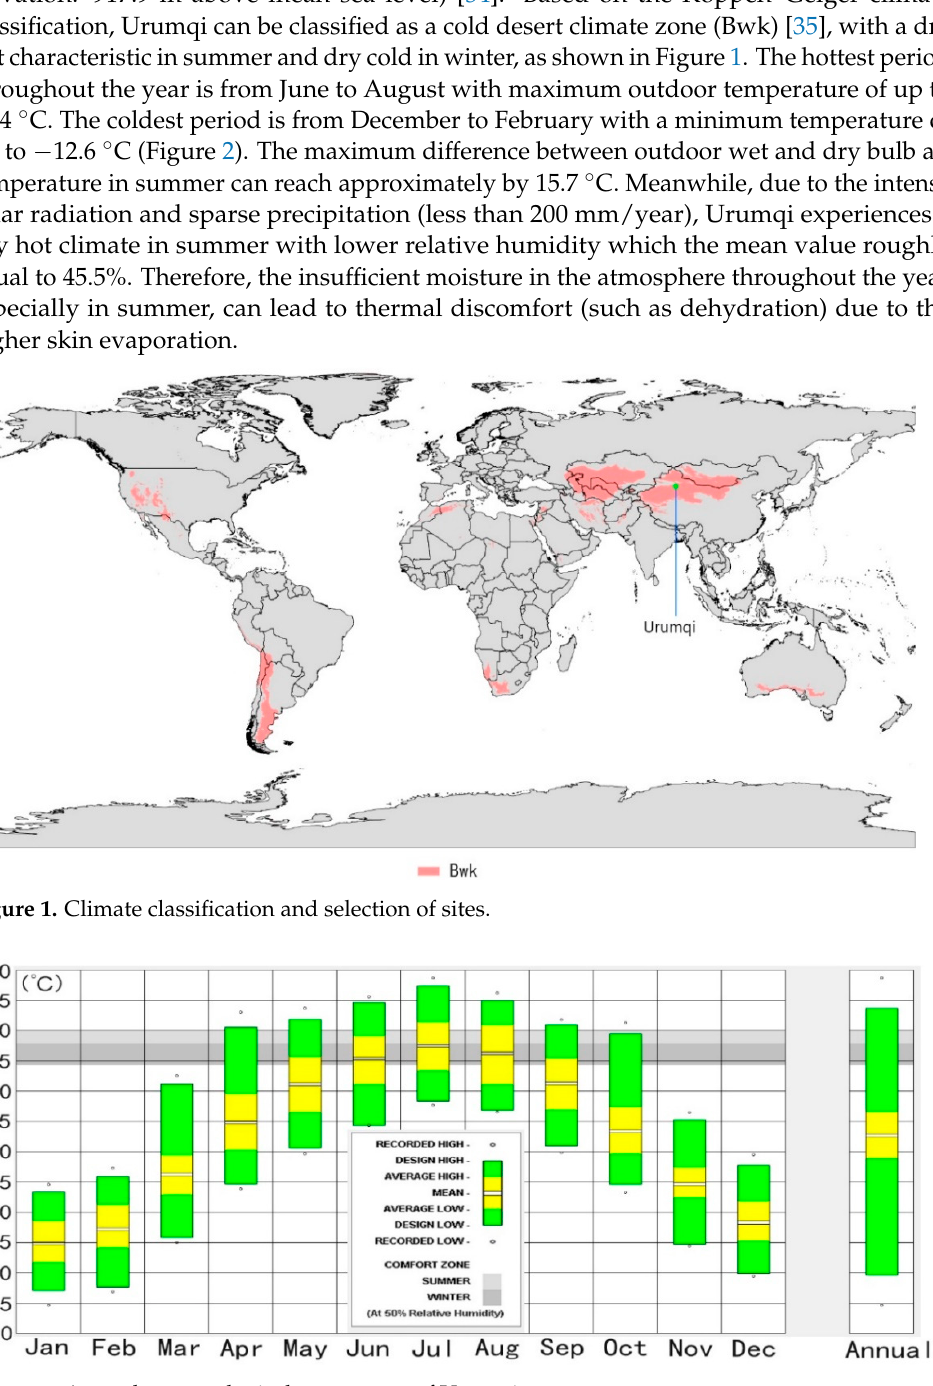
Figure 2. Annual meteorological parameters of Urumqi.